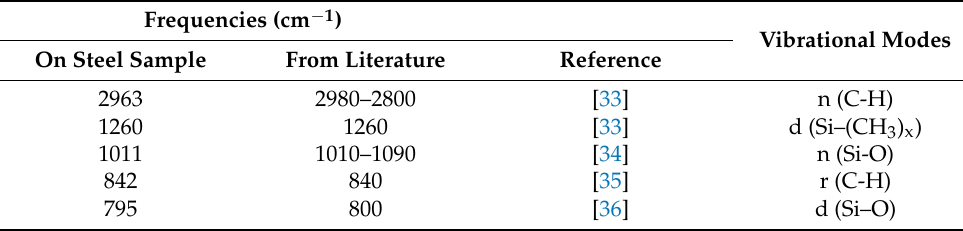
Figure 2. FT ‐ IR spectra (cm − 1 ) of untreated stainless steel disks and treated with nanoXHAM ® D coating. Table 1. Main vibration modes ascribable to the nanoXHAM ® D applied on the steel sample.